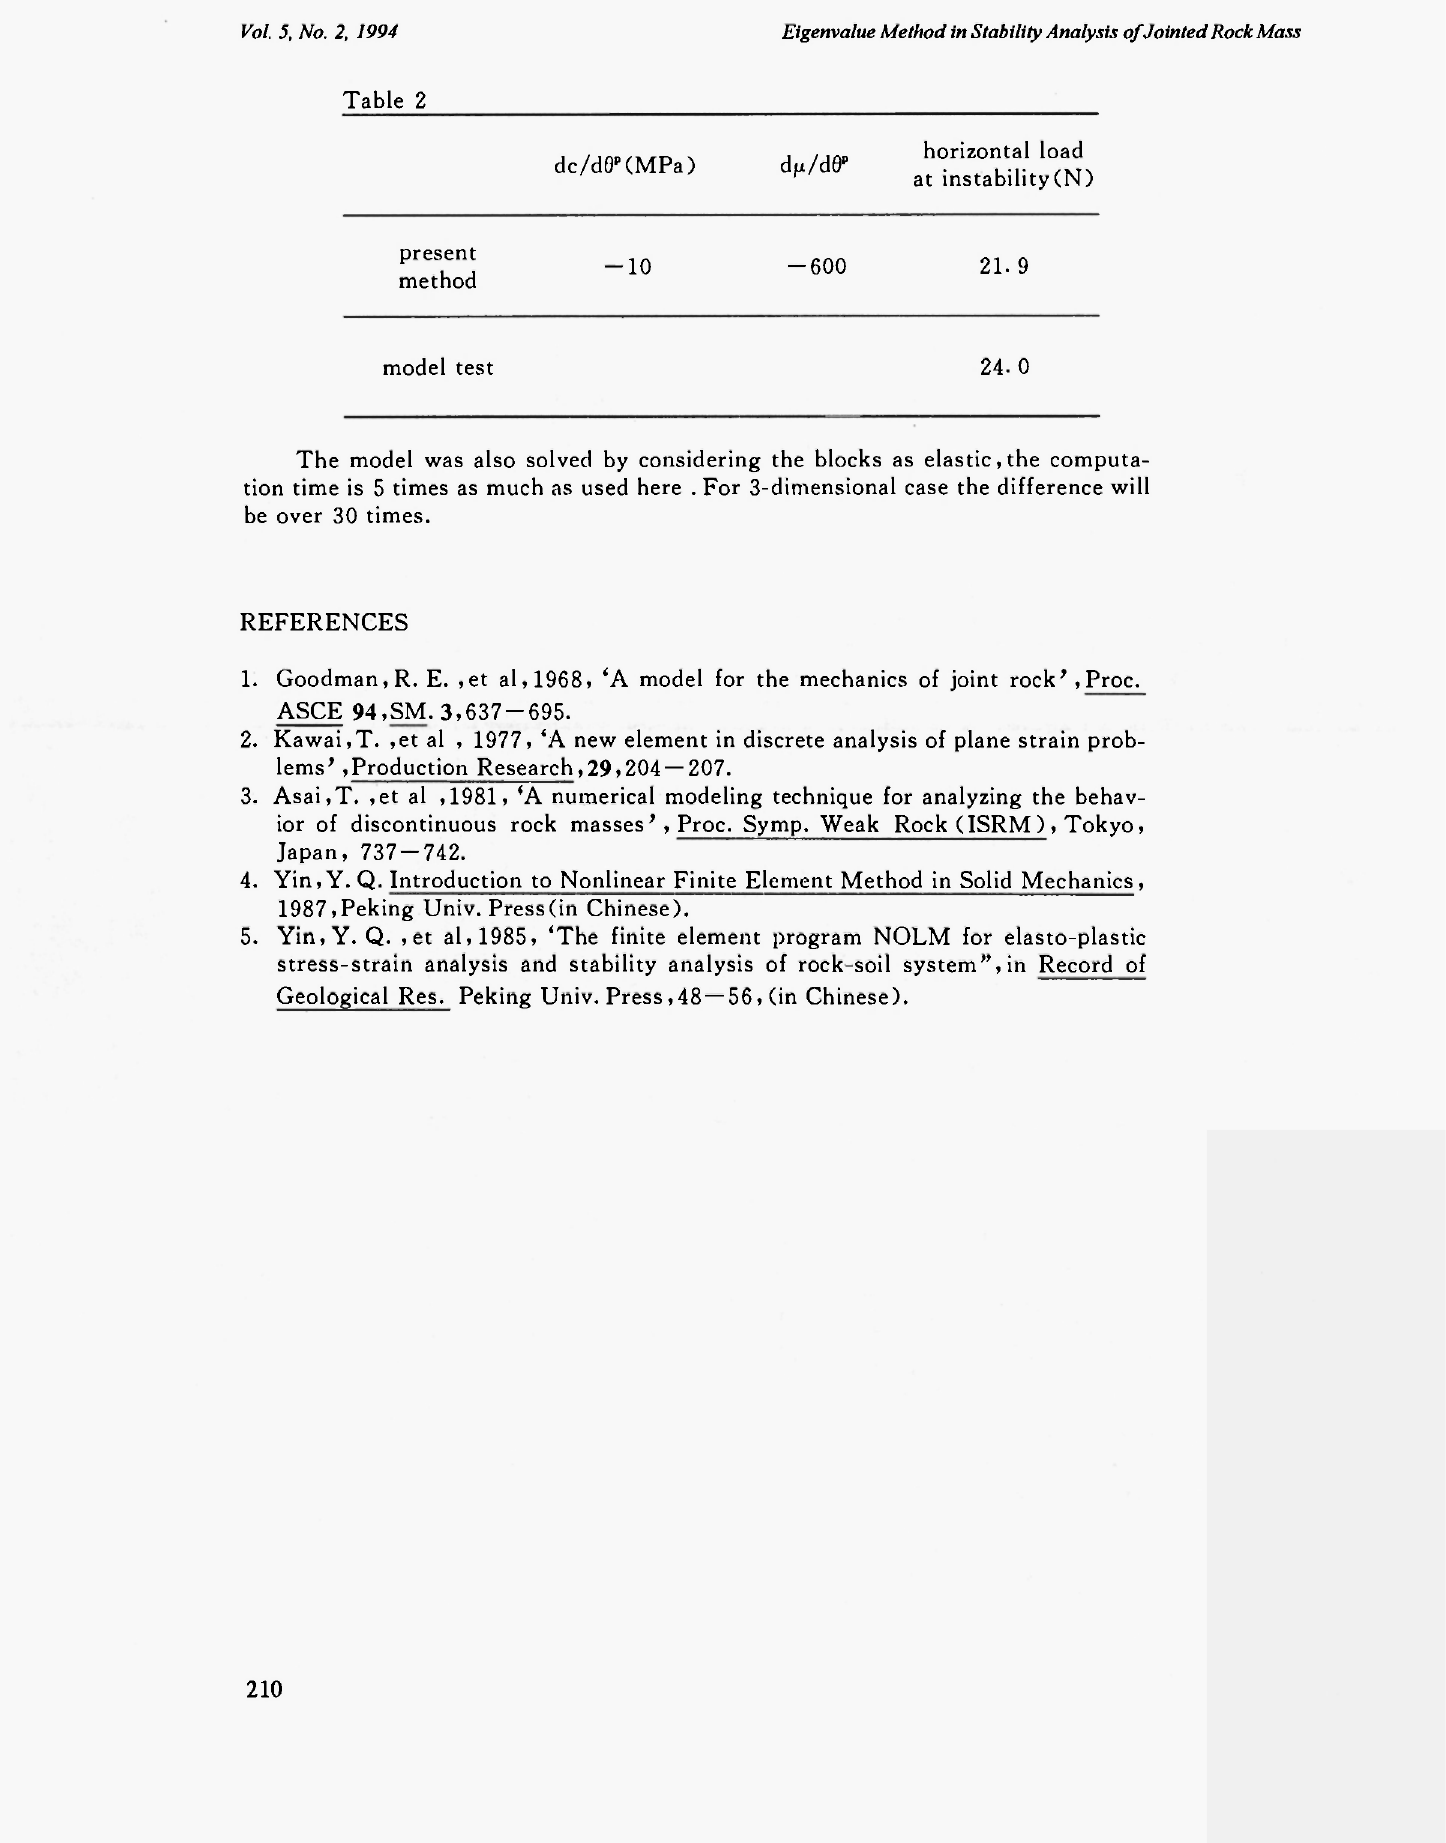
horizontal load at instability(N)